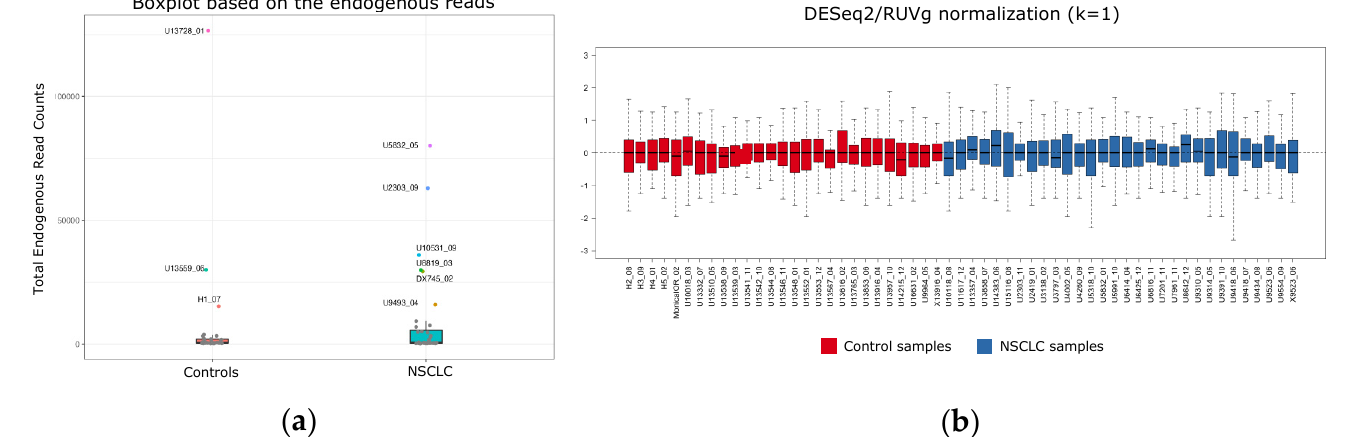
Figure 7. Data outlier detection and normalization for machine learning (ML) processing. ( a ) Outlier detection using the 1.5 IQR rule; ( b ) RUVSeq/DESeq2 RLE plot of normalized data (k = 1).